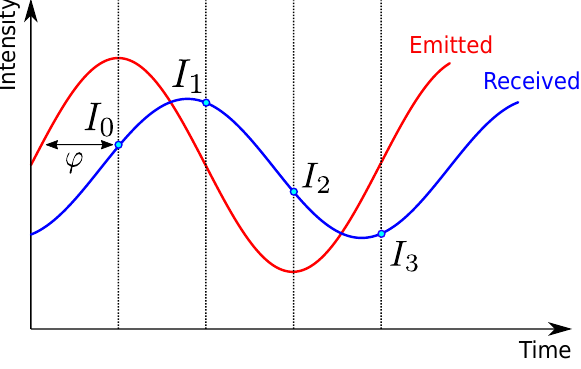
Figure 3. Overview of phase determination